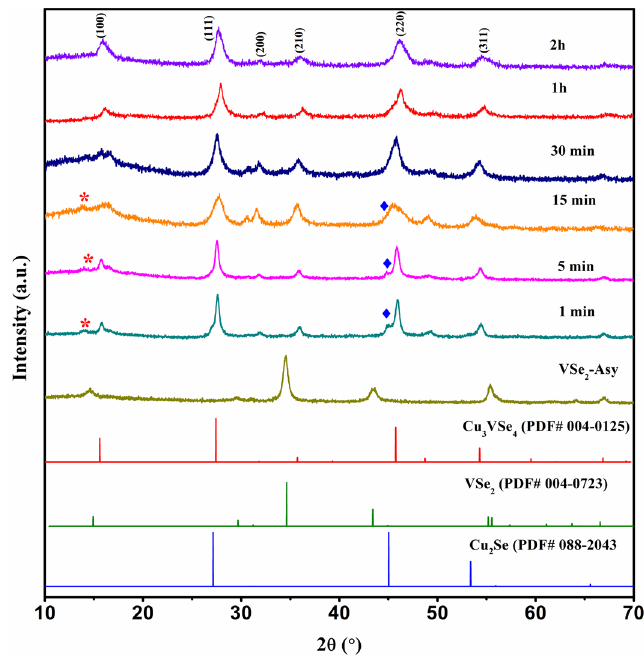
Figure 6. XRD patterns of Cu 3 VSe 4 product using different reaction time.